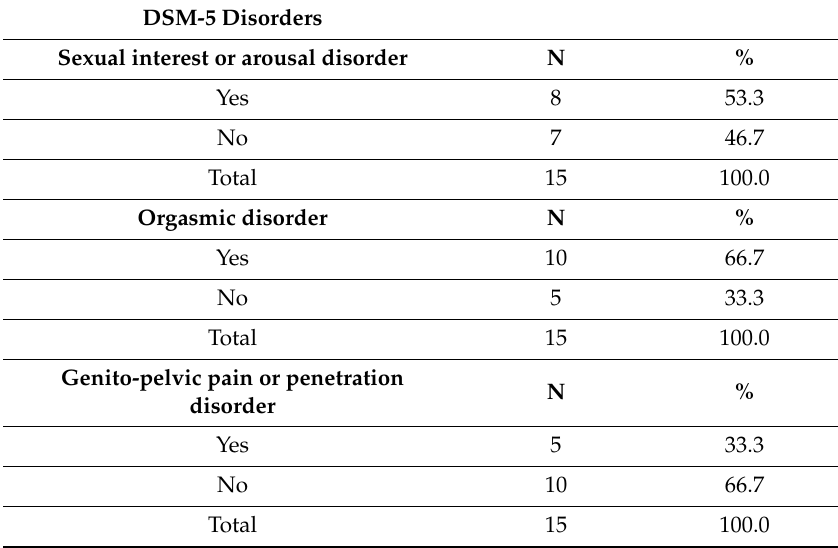
Table 2. Rates of DSM-5 sexual disorders among women in the longitudinal